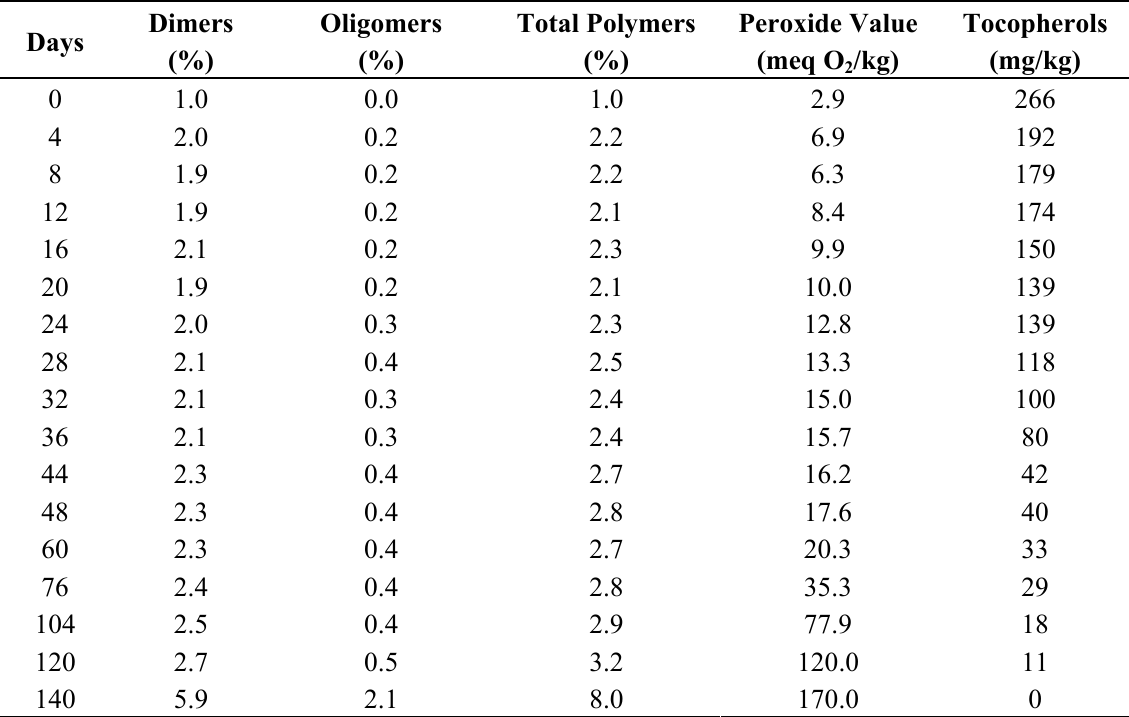
Table 2. Oxidation of safflower oil at 25